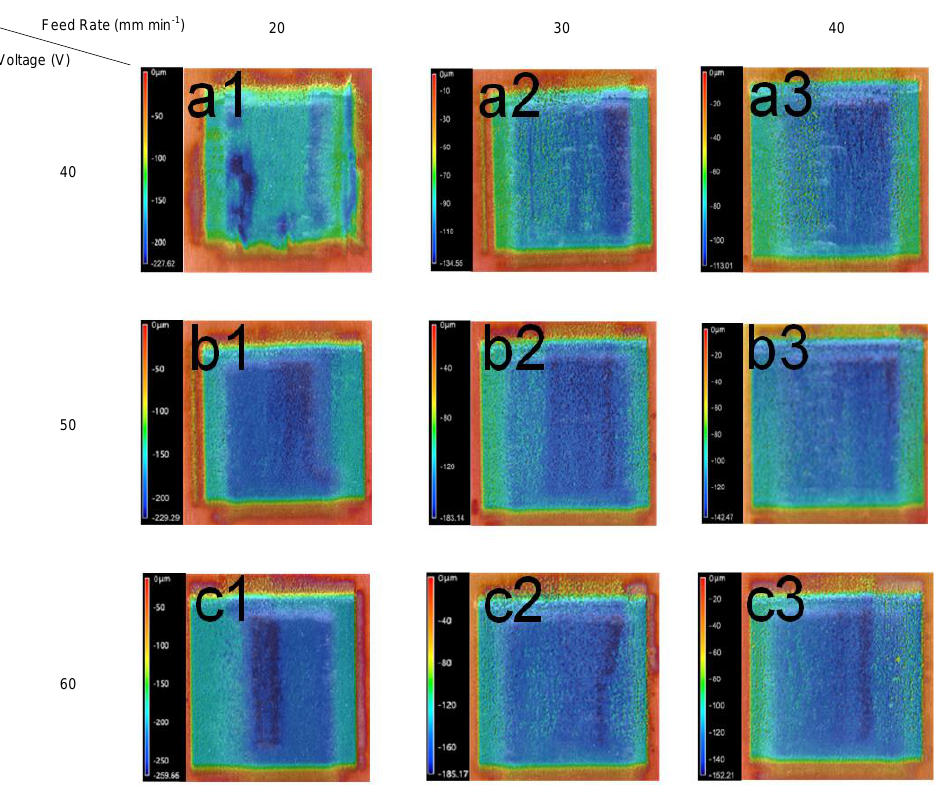
Figure 3. (TiB+TiC)/TC4 ECM surface 3D contour shape. The processing voltages of ( a1 - a3 ), ( b1 - b3 ), and ( c1 - c3 ) are constant at 40, 50, and 60 V, respectively. Regardless of ( a )/( b )/( c ), the feed rate is 20/30/40 mm min -1 from 1 to 3.